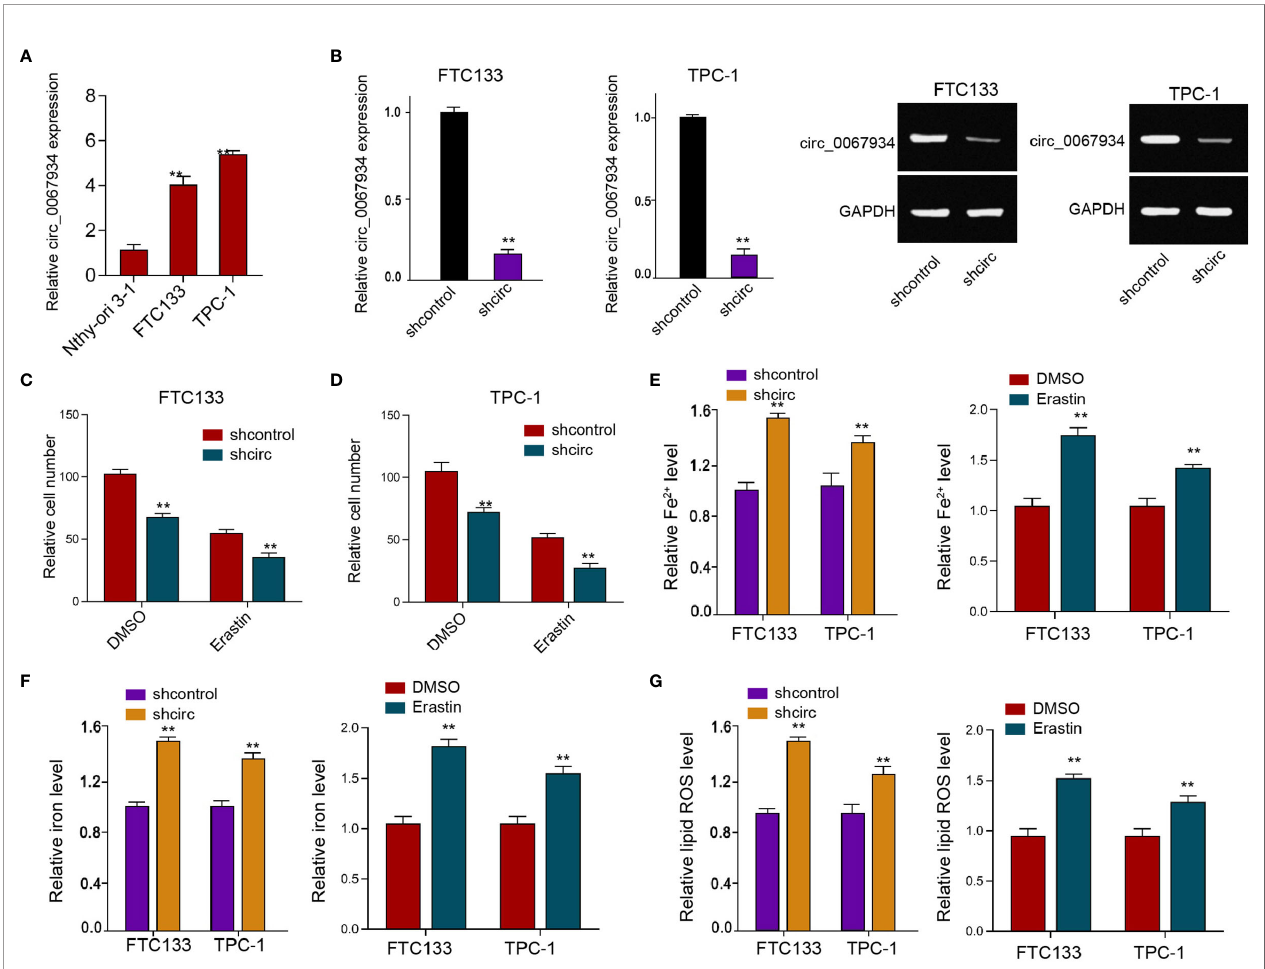
FIGURE 1 | Circ_0067934 attenuates ferroptosis of thyroid cancer cells. (A) The analysis of circ_0067934 expression in Nthy-ori 3-1, FTC133 and TPC-1 cells. (B) The measurement of circ_0067934 expression in FTC133 and TPC-1 cells by RT-qPCR and RT-PCR. (C, D) The analysis of FTC133 and TPC-1 cell viability by MTT assays. (E – G) Analysis of Fe 2+ , iron, and ROS levels in FTC133 and TPC-1 cells. mean ± SD, ** P <